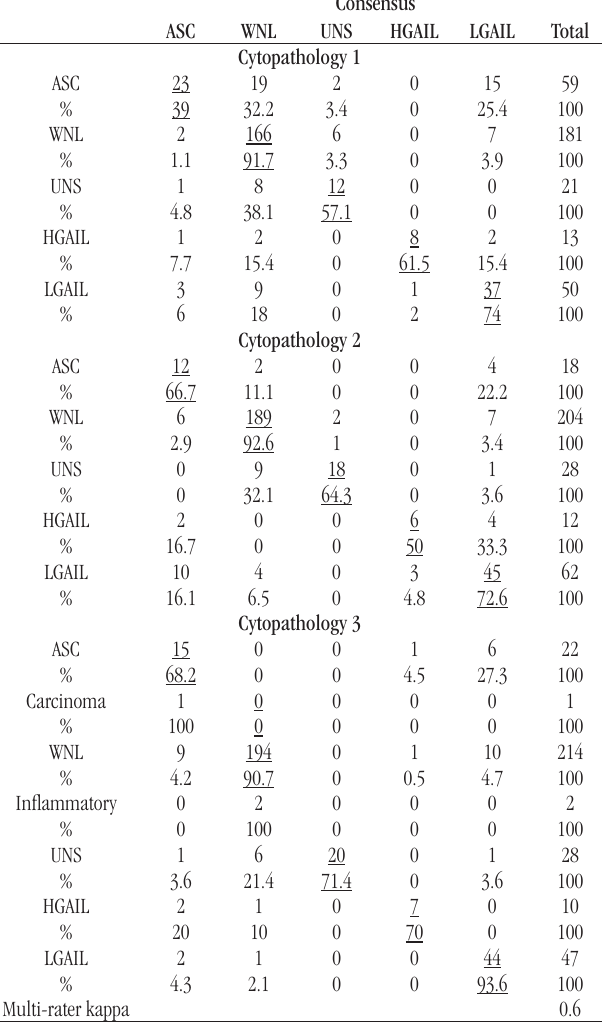
taBLE 2 – Absolute agreement among the three cytopathologists’ diagnoses and on the consensus diagnosis in anal cytologies of women with cervical neoplasia